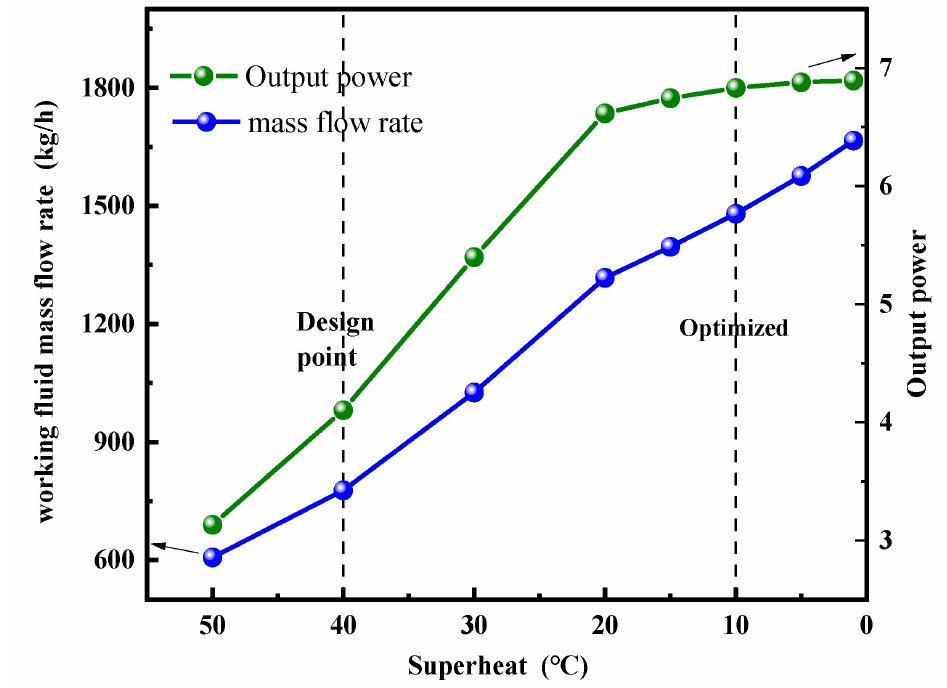
Figure 6. Effect of vapor superheat degrees on the output power of the ORC